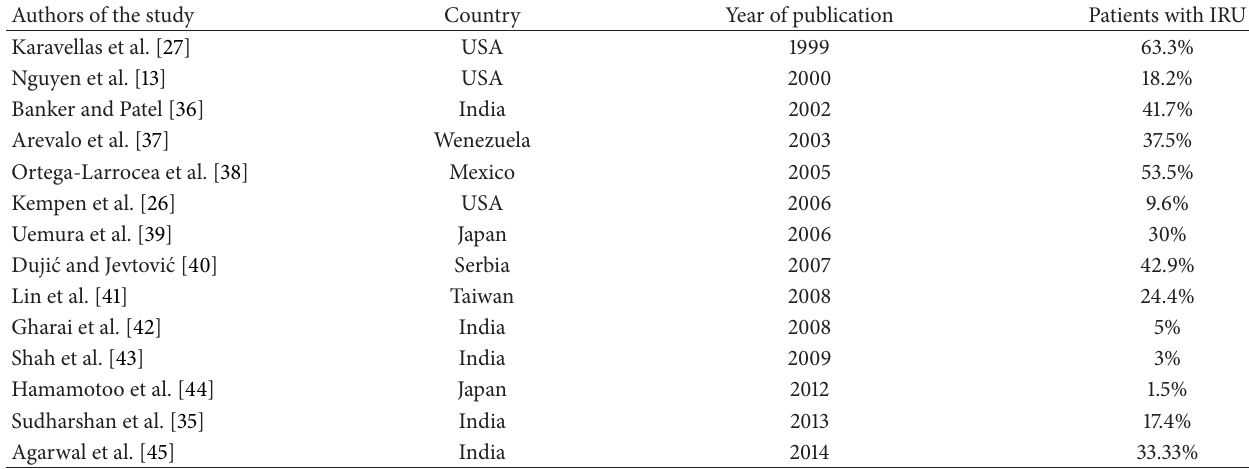
Table 2: Occurrence of IRU in patients starting HAART for HIV